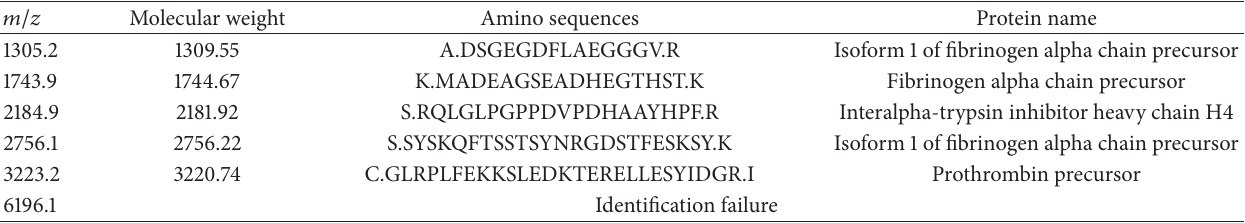
Table 3: Identified peptides sequence of the selected